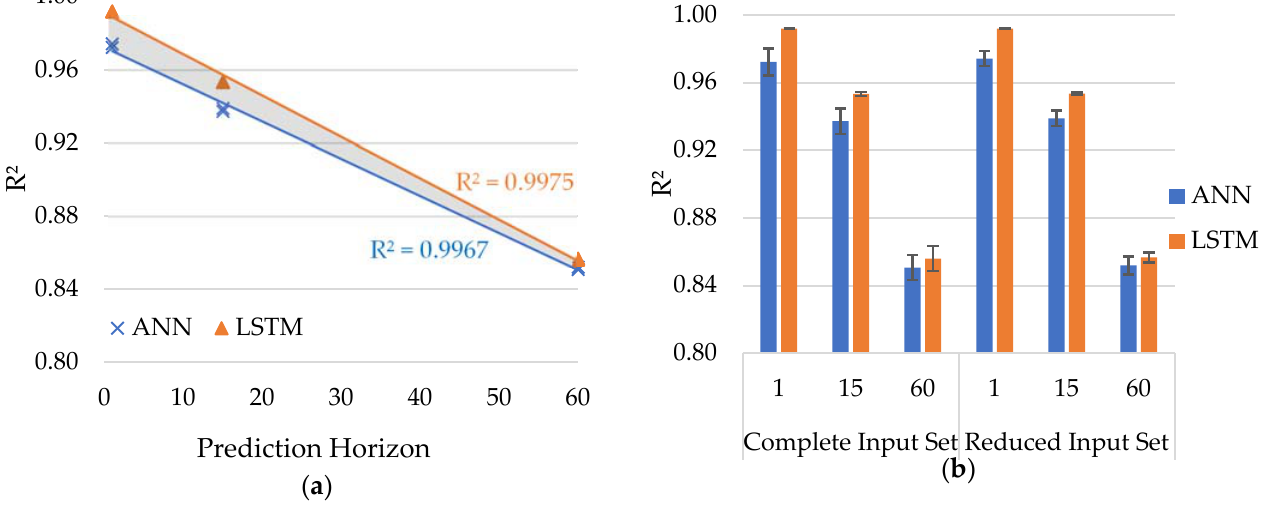
Figure 5. Prediction accuracy by prediction horizon of all ANN and LSTM models: ( a ) mean R 2 accuracy and linear fit of models by prediction horizon and ( b ) R 2 accuracy by input set and horizon prediction.